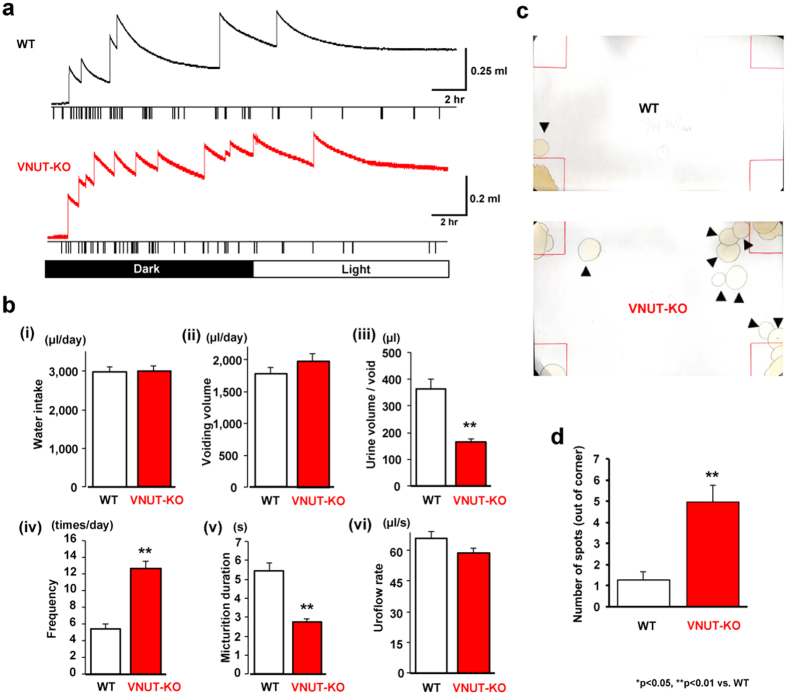
Voiding behaviour and water intake in WT and VNUT-KO mice.(a) Representative 24-h voided urine and water intake records from WT and VNUT-KO mice in metabolic cages. Each rapid increase in weight was evaluated as the volume of voided urine. Each spike is presented as ‘water-intake’ and indicates a decrease of 16.7 μl. (b) Results of 24-h frequency/volume analysis of WT (n = 13) and VNUT-KO (n = 9) mice. (i) Water intake volume per day. (ii) Urine volume per day. (iii) Mean urine volume per void. (iv) Voiding frequency per day. (v) Micturitional duration. (vi) Uroflow rate. Data are mean ± SEM. *P < 0.05, **P < 0.01 (Student’s t-test) (c) Spontaneous voiding pattern of unrestrained WT and VNUT-KO mice in large cages. Photographs of filter papers with urine spots from the WT or VNUT-KO mice are shown. Urine spots are distinguished by their yellowish colour and are outlined in black. Arrowheads show urine spots outside of the corner area. (d) Mean number of spots outside of the corner area in WT and VNUT-KO mice. Data are mean ± SEM. P < 0.01 (Student’s t-test).